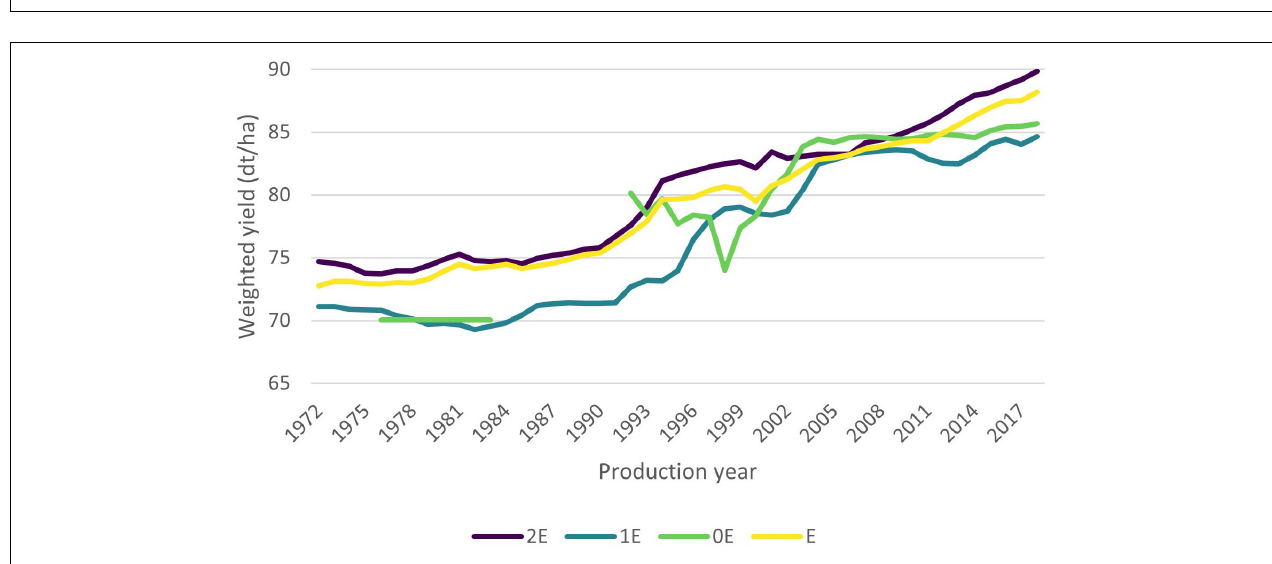
FIGURE 1 | Development of multiplication area per group over time. Source: Authors’ calculations.